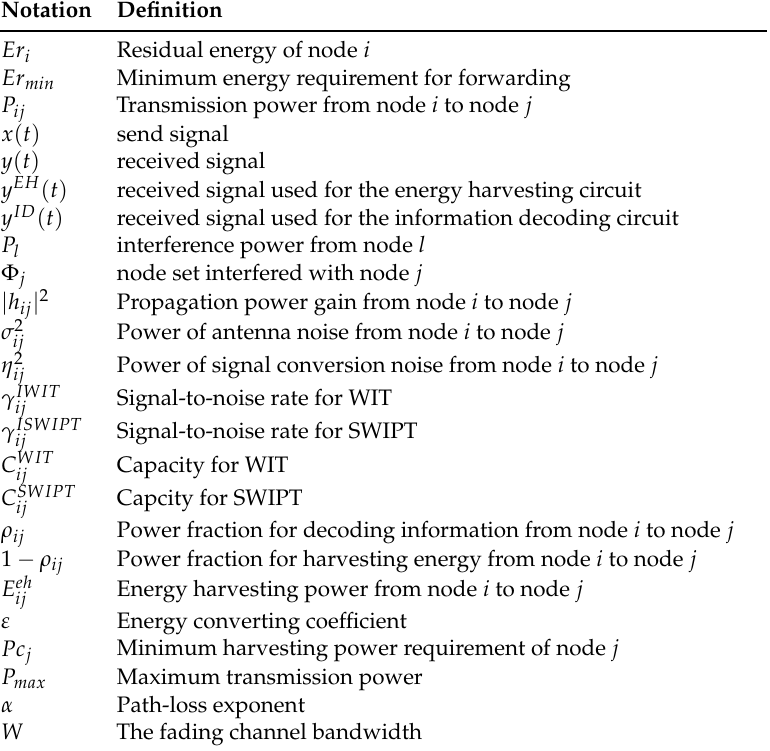
Table 1. Summary of notations.